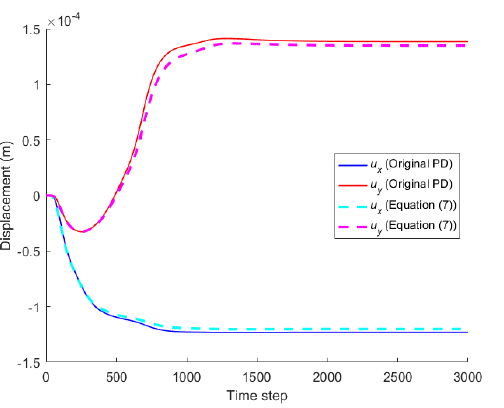
Figure 11. The plate subjected to bending.